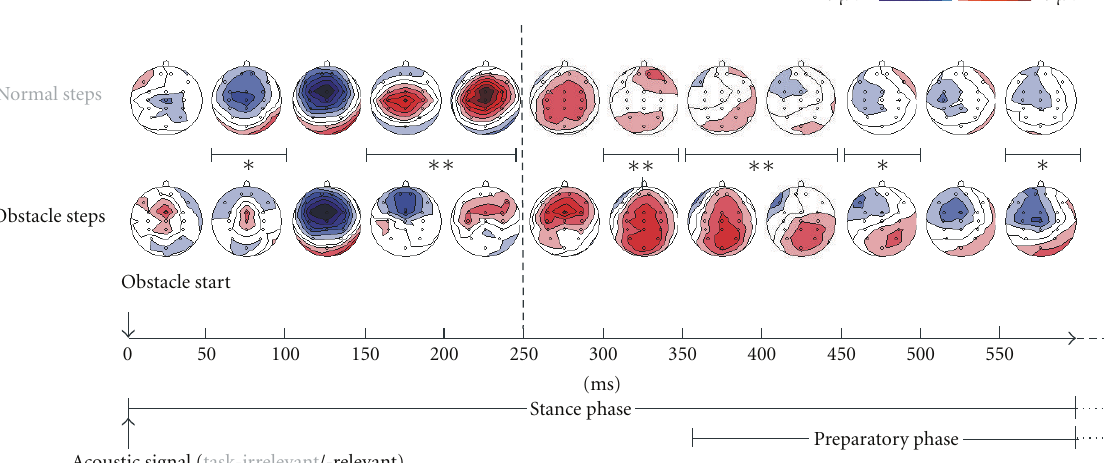
Figure 7: EEG activity during normal and obstacle steps performed on a treadmill. Grand averages of the initial EEG activity and topography (32 EEG electrodes placed on the scalp) from 12 subjects. The stance and swing phases were determined by the time period where all 12 subjects were on stance and swing (i.e., the individually shortest stance and swing phases, resp.). In normal steps a task-irrelevant and in obstacle steps a task-relevant acoustic signal was delivered at the onset of the right stance phase. Significant di ff erences are indicated by asterisks ( ∗ P < 0 . 05, ∗∗ P < 0 . 01) (modified with permission of Figure 3 from Haefeli et al.